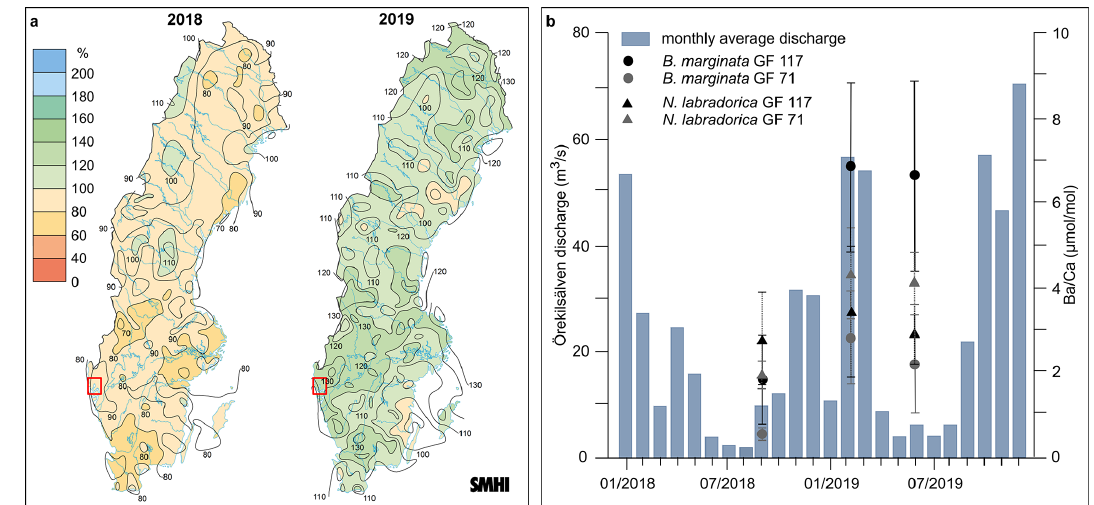
Figure 2. (a) Maps of Sweden showing annual average runoff in 2018 and 2019 compared to reference period 1961–1990 (SMHI), with study area marked by red rectangle. (b) Average monthly river discharge of Örekilsälven across 2018 and 2019 with median Ba / Ca with MAD per investigated species ( n -chambers) and site indicated.